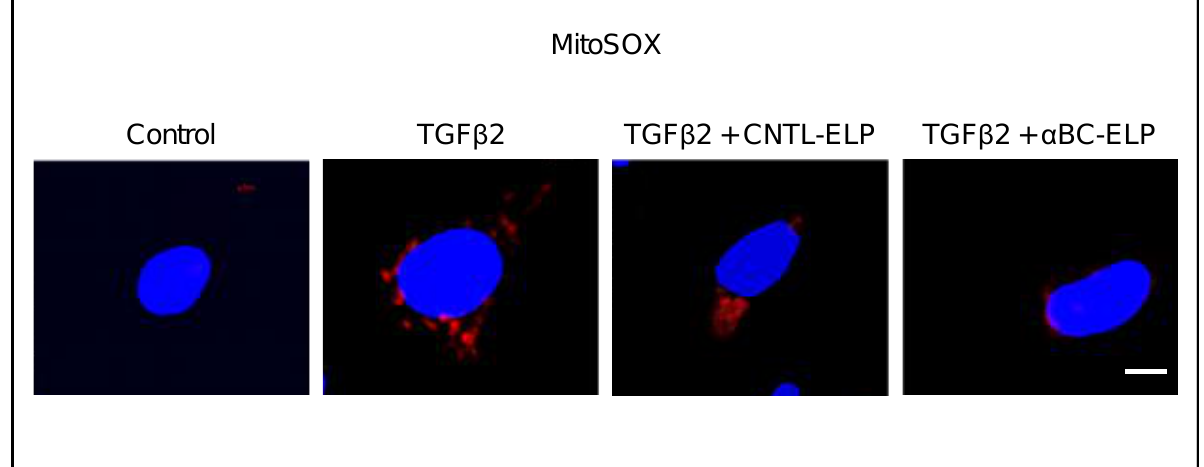
Figure 3. Effect of TGFβ2 on ROS generation and inhibition of ROS by α BC-ELP. hRPE cells were cultured in 4 well chamber slides. Twenty four hour after treatment with TGFβ2 (10 ng /mL) or co- treatment with TGFβ2 (10 ng /mL) and α BC-ELP or co- treatment with TGFβ2 (10 ng /mL) and CNTL-ELP, cells were incubated with 5 µM MitoSox Red (mitochondrial superoxide marker) for 10 min at 37 °C . After washing, cells were imaged with a confocal microscope (ZEISS LSM 710).TGFβ2 at 10 ng/mL (24 h) noticeably increased mitochondrial ROS production in RPE cells and co-treatment with α BC-ELP at 10 µM inhibit ed TGFβ2 -induced ROS formation. SI is used as negative control (CNTL-ELP). Red: Mitochondrial superoxide, Blue, DAPI, nuclear stain. Scale bar : 10 µm.